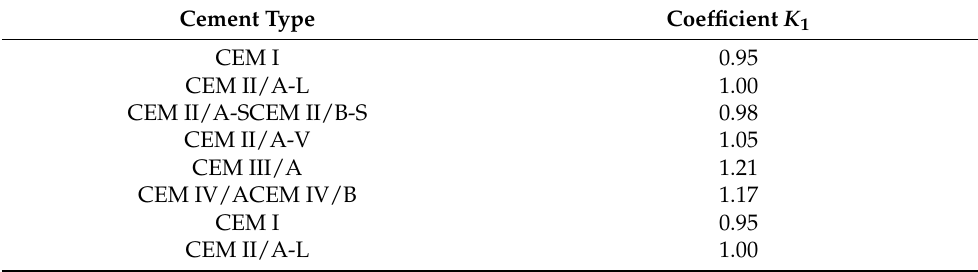
Table 3. Model coefficients as a function of the cement type [59].